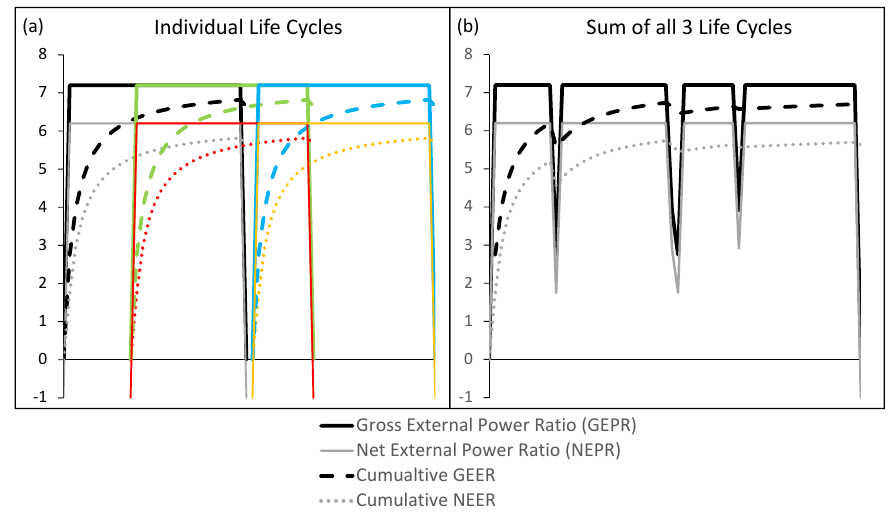
Figure 4. This figure shows that when multiple technologies are installed over time, the instantaneous power return ratios (PRRs) and the cumulative energy return ratios (ERRs) can end up greater than or less than each other (but gross external energy ratio (GEER) > NEER and gross external power ratio (GEPR) > net external power ratio (NEPR)). ( a ) Individual gross external power ratio (GEPR), net external power ratio (NEPR), cumulative gross external energy ratio (GEER) and cumulative net external energy ratio (NEER) for each of the three technology installations based on the time of installation; ( b ) the summed GEPR, NEPR, GEER and NEER from all three technology